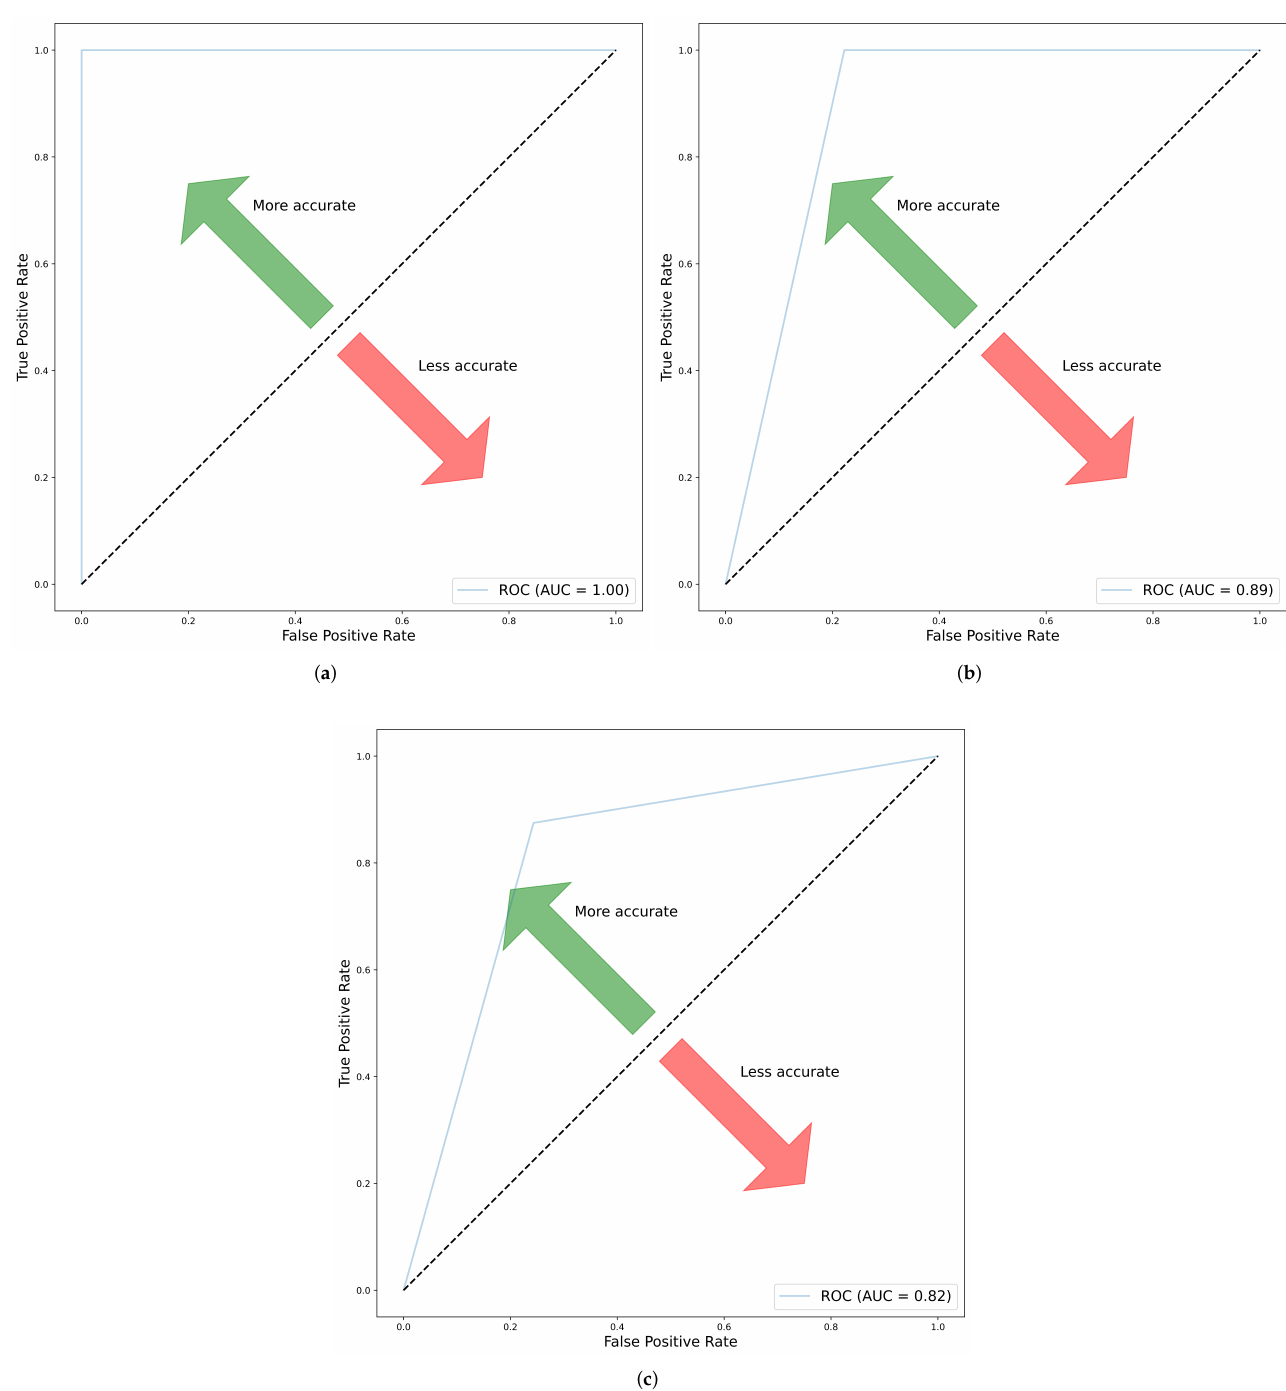
Figure A3. ( a ) ROC RF Per Patient Prediction Original Cohort 1. ( b ) ROC KNN Per Patient Prediction Filtered Cohort 2. ( c ) ROC KNN Per Patient Prediction Filtered Combined